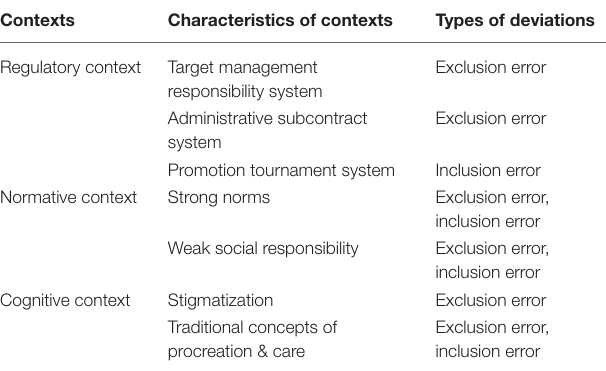
TABLE 5 | Contexts and types of